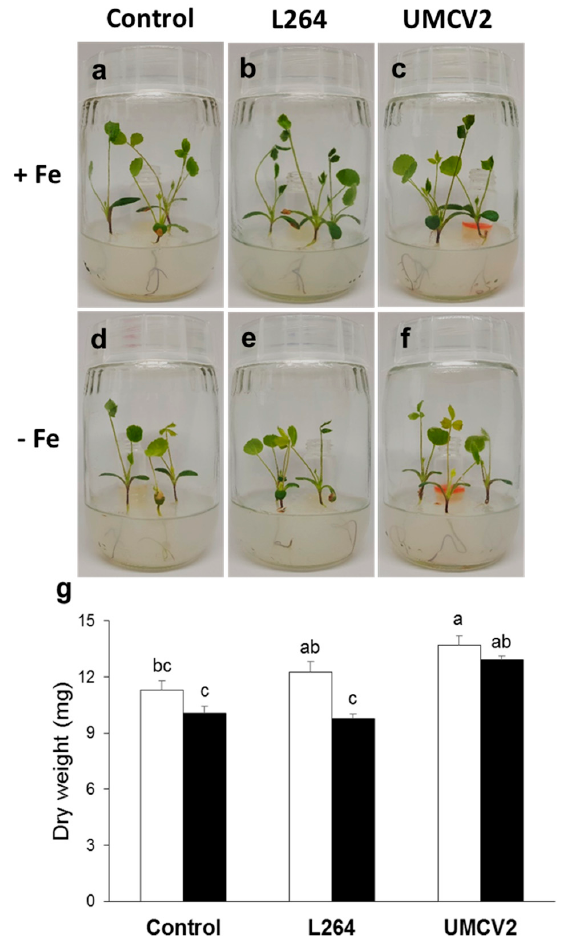
Figure 1. Interaction between Medicago truncatula and rhizobacteria through the emission of volatile compounds. A 4 mL glass vial with 2 mL nutritive agar medium was inserted in each system; in the control system, 20 µ L water was added into the vial instead of the bacterial inoculum. The interaction lasted for 10 days. Uninoculated 12-day-old plants grown under conditions of iron (Fe) sufficiency ( a ) and deficiency ( d ). ( b ) Plants were inoculated with the commensal strain Bacillus sp. L264 grown under Fe-sufficient and -deficient conditions ( e ). Inoculated plants exposed to volatiles from A. agilis UMCV2 and under Fe-sufficient ( c ) and -deficient conditions ( f ). ( g ) Dry weights of control plants and plants during interactions with bacterial volatile compounds. Data shown are means ± standard error (n = 15). White and black bars indicate Fe-sufficient and -deficient growth conditions, respectively. Different letters indicate significant differences ( p ≤ 0.05) among treatments determined with two-way ANOVA and Tukey’s test.